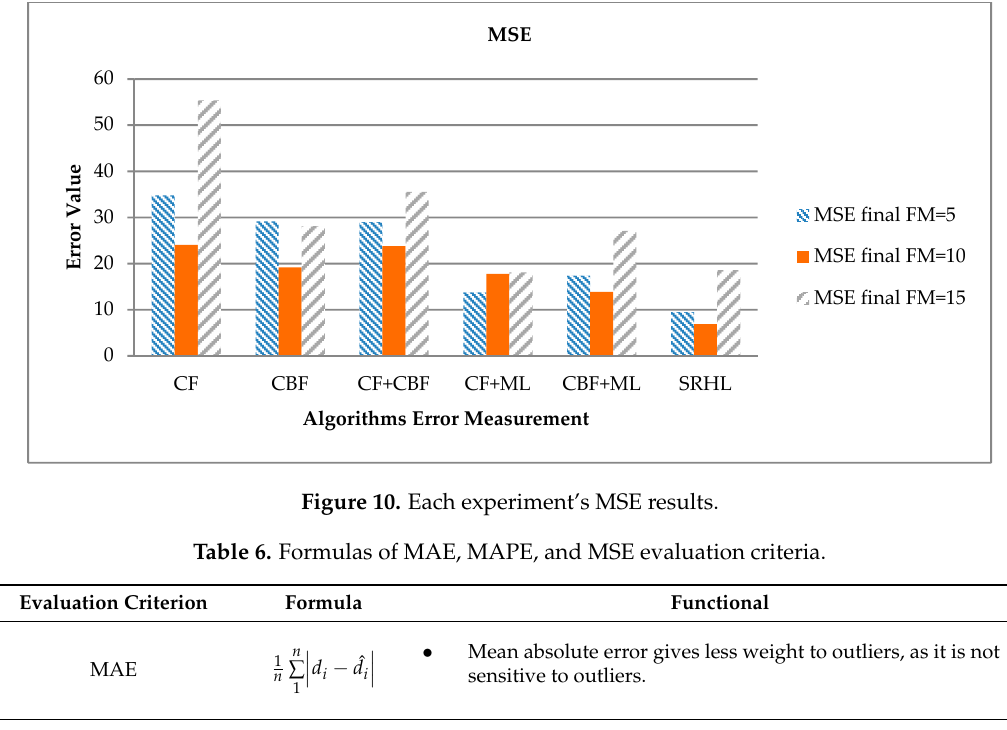
Figure 9. Each experiment’s MAPE results .